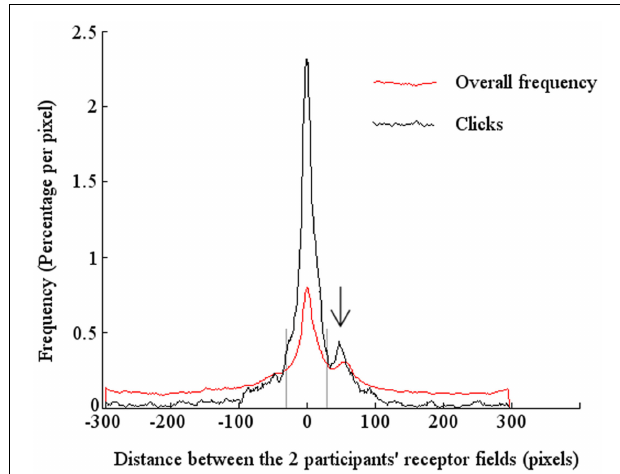
FIGURE 4 | Distribution of frequencies as a function of the distance between the receptor fields of the two participants. The fine line represents the total frequency of clicks made: 62% of the distribution lies between ± 30pixels.The thick line represents the total frequency of stimulations received by the subjects: 28% of the distribution lies between ± 30pixels. In both cases, there is a clear peak around the distance 0pixels, i.e., the situation of perceptual crossing, which shows that there is an attractor at this point, at least in the weak descriptive sense that once the subjects have attained the situation of perceptual crossing they tend to remain in this stable dynamic configuration. A minor peak at the distance of 50pixels (marked by an arrow) corresponds to the mobile lure.